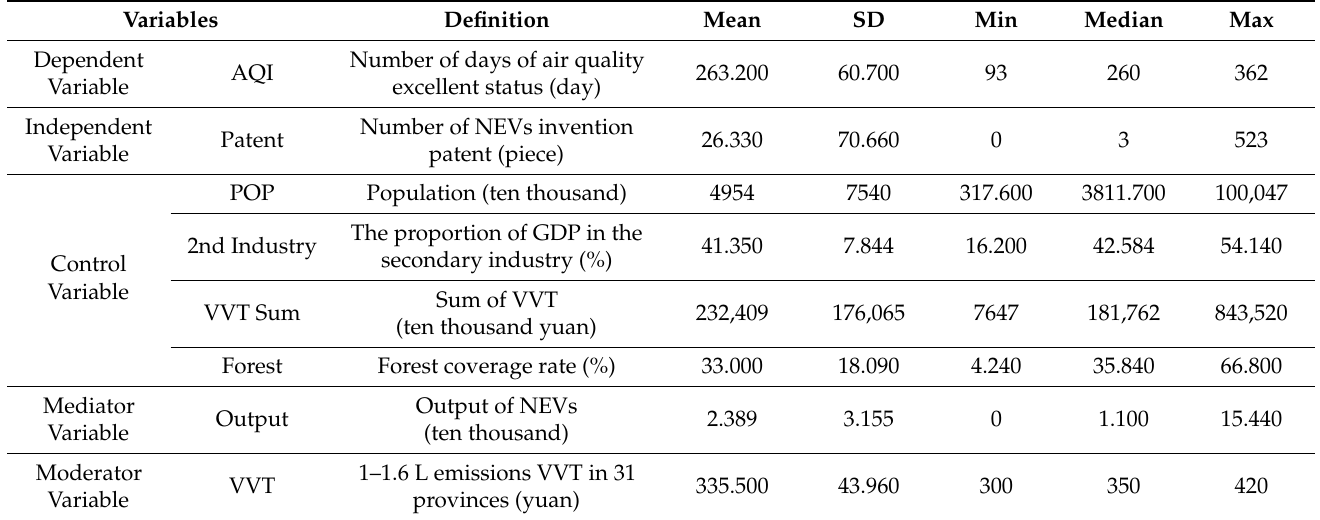
Table 1. Descriptive statistics.